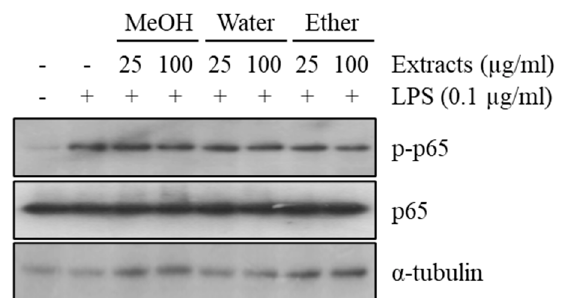
Figure 5. Effect of sweet potato extracts on p65 phosphorylation in the Raw264.7 mouse macrophage cell line. Raw264.7 cells were pre-treated with sweet potato MeOH, water, or ether extract and then treated with LPS. Phosphorylation of p65 was assessed by Western blotting. All Western blot results were quantified by using Image J.